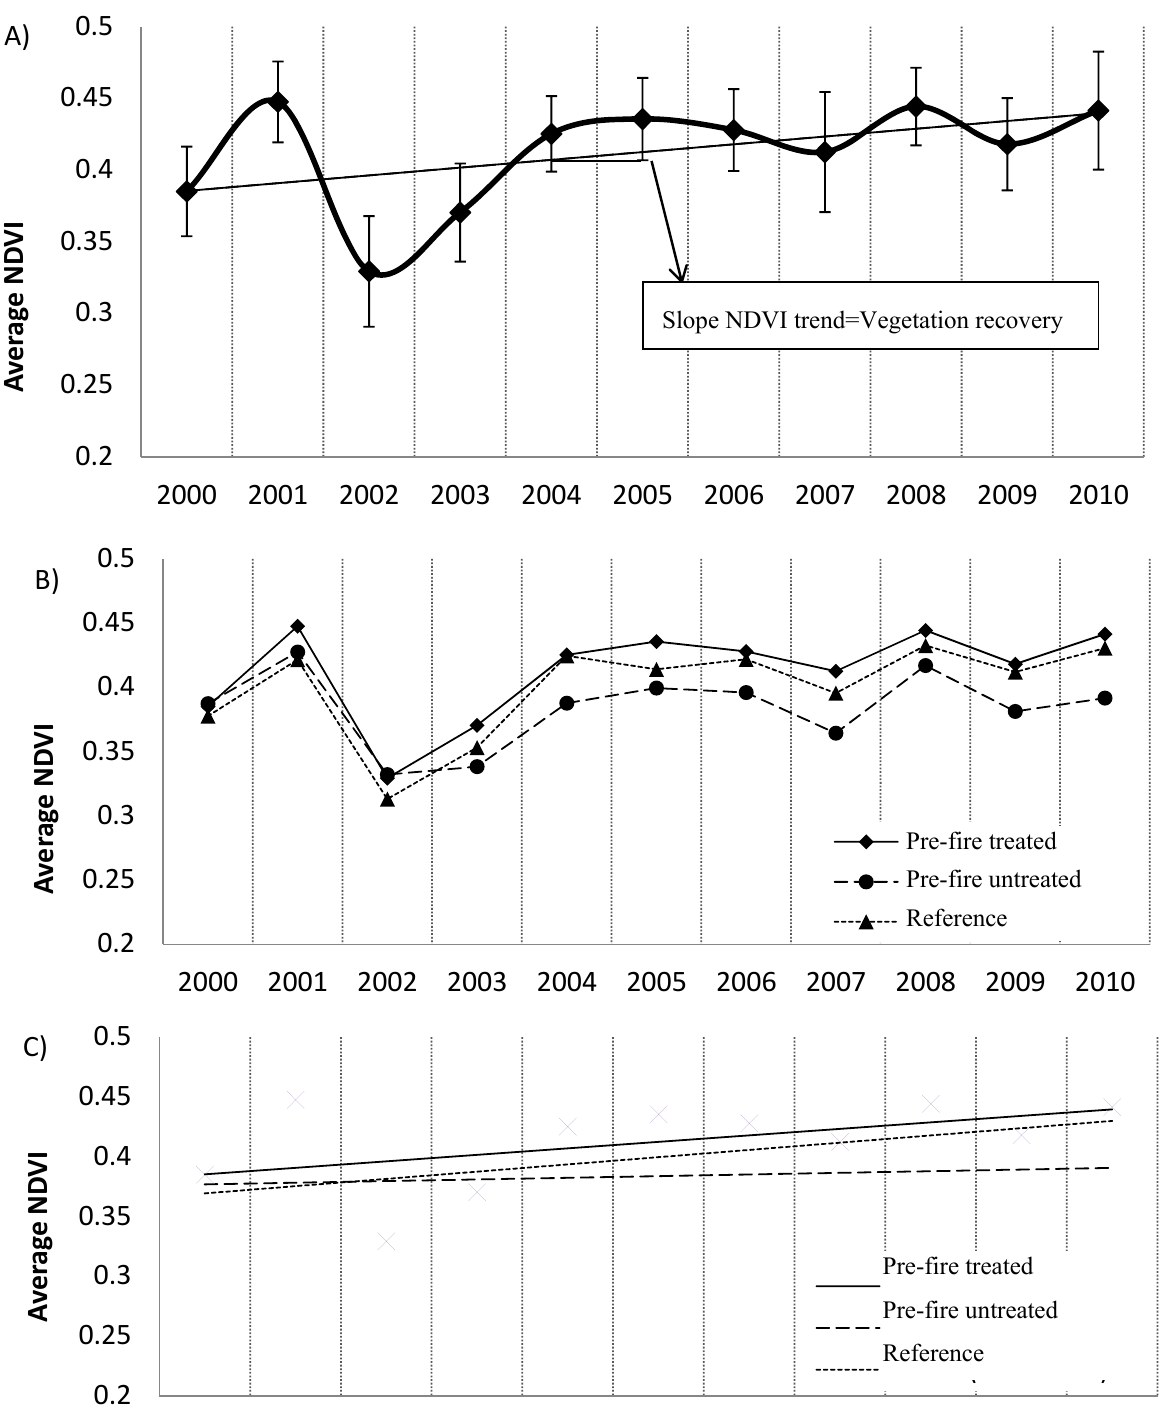
Figure 4. ( A ) Example of how the response variable was derived, for each of the MODIS pixels in one of our study sites (Mid Elevation Mesa fire, 1999). Vegetation trend was calculated by extracting the slope of a linear model, fitted with the NDVI integrations of the monsoons after the fire. ( B ) Example of how vegetation responses differ from treatments within fires. ( C ) The linear trends derived from the data in (B). Average NDVI is calculated for growing season periods 13 to